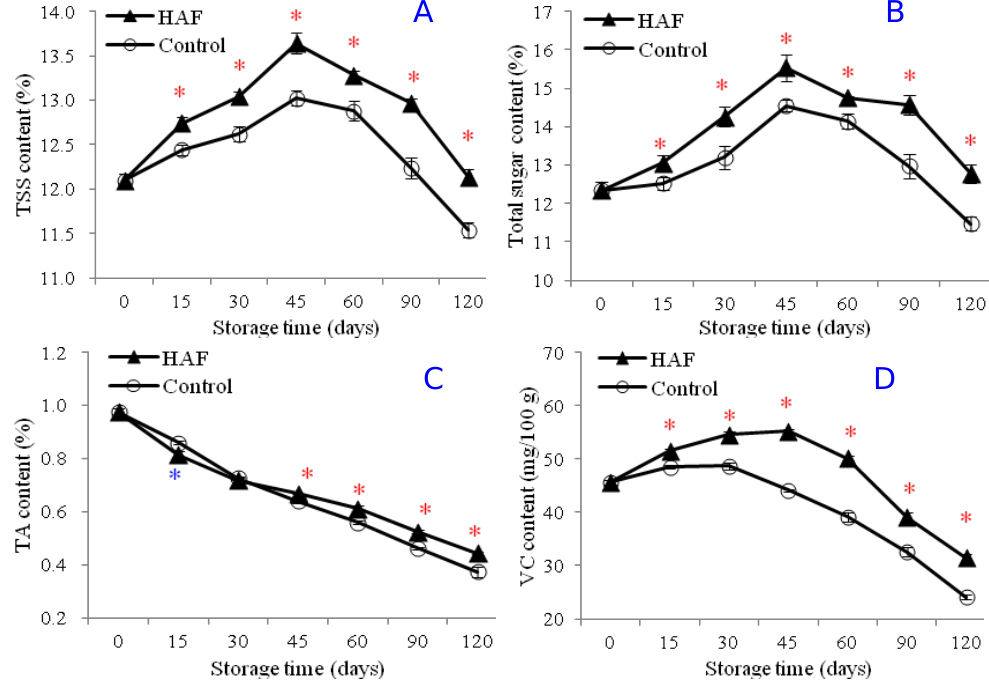
Figure 2. Effects of HAF treatment on the contents of TSS ( A ), total sugar ( B ), TA ( C ), and VC ( D ) of navel orange fruits during 120 days of cold storage at 6 °C. Each value was presented as the mean ± standard error (SE) of three replicates. The symbols * and * represent significantly higher and lower values, respectively, for the HAF-treated fruits than for the control fruits. The significant difference was determined according to the independent samples t -test ( P < 0.05) on each storage day.